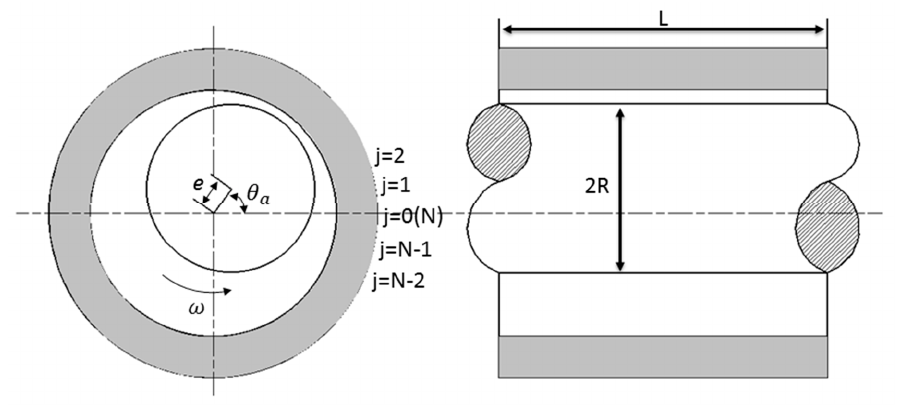
Figure 1. Schematic structure of the air journal bearing.